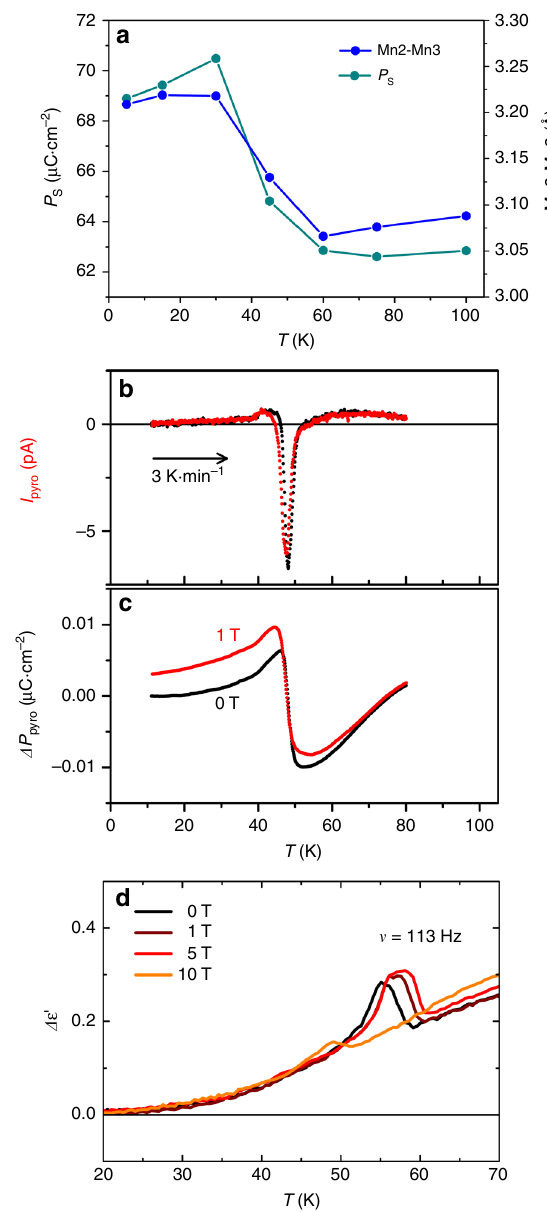
Fig. 4 Magnetostriction-polarization coupling and pyroresponse in Mn 2 MnWO 6 . a Temperature dependent spontaneous polarization ( P S , calculated) and Mn2-Mn3 distance evolution in Mn 2 MnWO 6 between 5 and 100 K. b Pyro-current as a function of temperature between 10 and 80 K, and c Pyroelectric polarization measured in 0 and 1 T upon warming and normalized to a common high temperature value. d Temperature dependent dielectric data between 0 and 10 T show anomalies around T N and indicate magnetoelectric coupling vector k = 0 0 0.6107(8) ( k = (0 0 0.305) with respect to the nuclear unit cell). We cannot rule out the possibility of similar magnetic structures giving equally good fi ts to the data, but the constraints imposed give almost equal moments for each man- ganese site and across the magnetic structure as might be expected for this insulating oxide. The magnetic and crystal structures at 5 K are shown in Fig. 3 and re fi nement pro fi les in Supplementary Fig. 10. Re fi nement details and selected bond lengths and distances are given in Supplementary Tables 4 and 5.